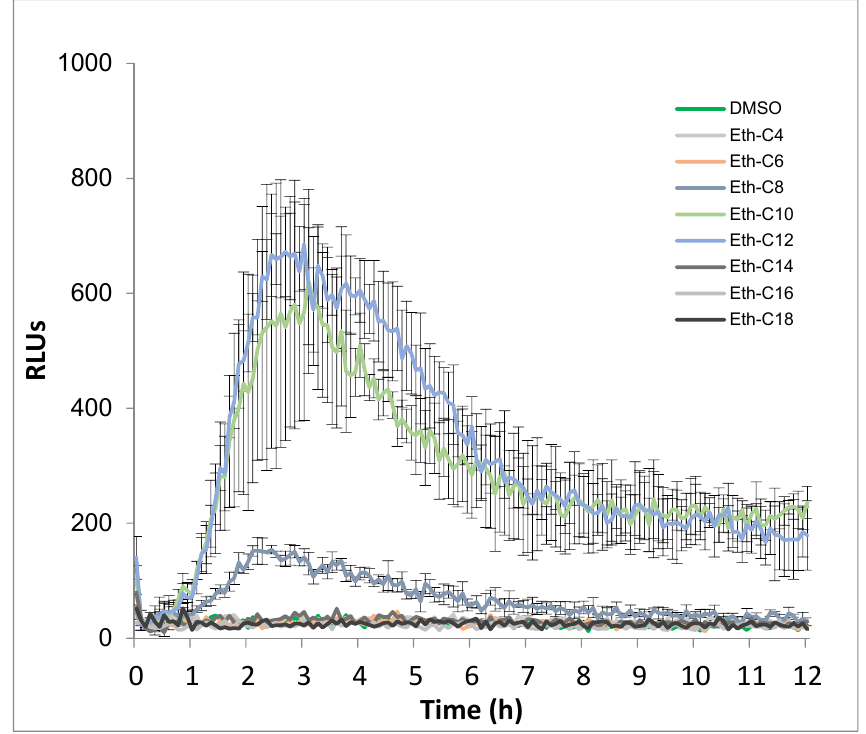
Figure 1. Production of reactive oxygen species (ROS) in tomato leaf disks after treatment with ether-synthetic mono-rhamnolipids (Eth-smRLs) exhibiting different carbon chain lengths at 100 µM. Dimethyl sulfoxide (DMSO; 0.1%) was used as control. ROS production was measured using the chemiluminescence of luminol and photon counts were expressed as relative luminescence units (RLUs).